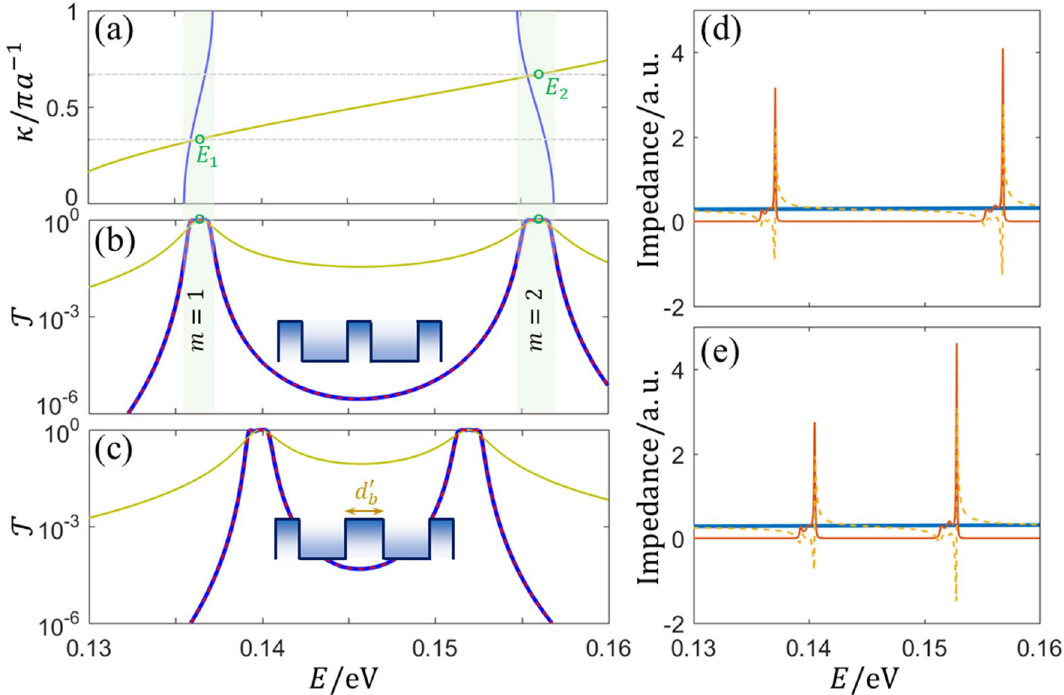
Figure 4. ( a ) Band structures of periodic triple-barrier (InP/InAs/InP/InAs/InP) infinite superlattice (blue line) and periodic single-barrier (InP/InAs) infinite superlattice (doderblue line), where d b nm. ( b ) Transmission spectra for 3-period superlattice with the unit cell of periodic triple-barrier (blue line) and for the unit cell itself (doderblue line), the dashed red line indicates the results from the theory of QMWI. Circles mark peaks in transmission spectra of unit cells. ( c ) Transmission spectra of 3-period superlattice with symmetric triple-barrier unit cell when the middle barrier width is d ′ b itself (doderblue line), the dashed red line indicates the results from the theory of QMWI. ( d ) and ( e ) are the corresponding impedances of the ( b ) and ( c ), respectively, where the bold solid line indicates Z 1,0 , and the fine lines indicate the real parts (solid lines) and imagine parts (dashed lines) of Z S